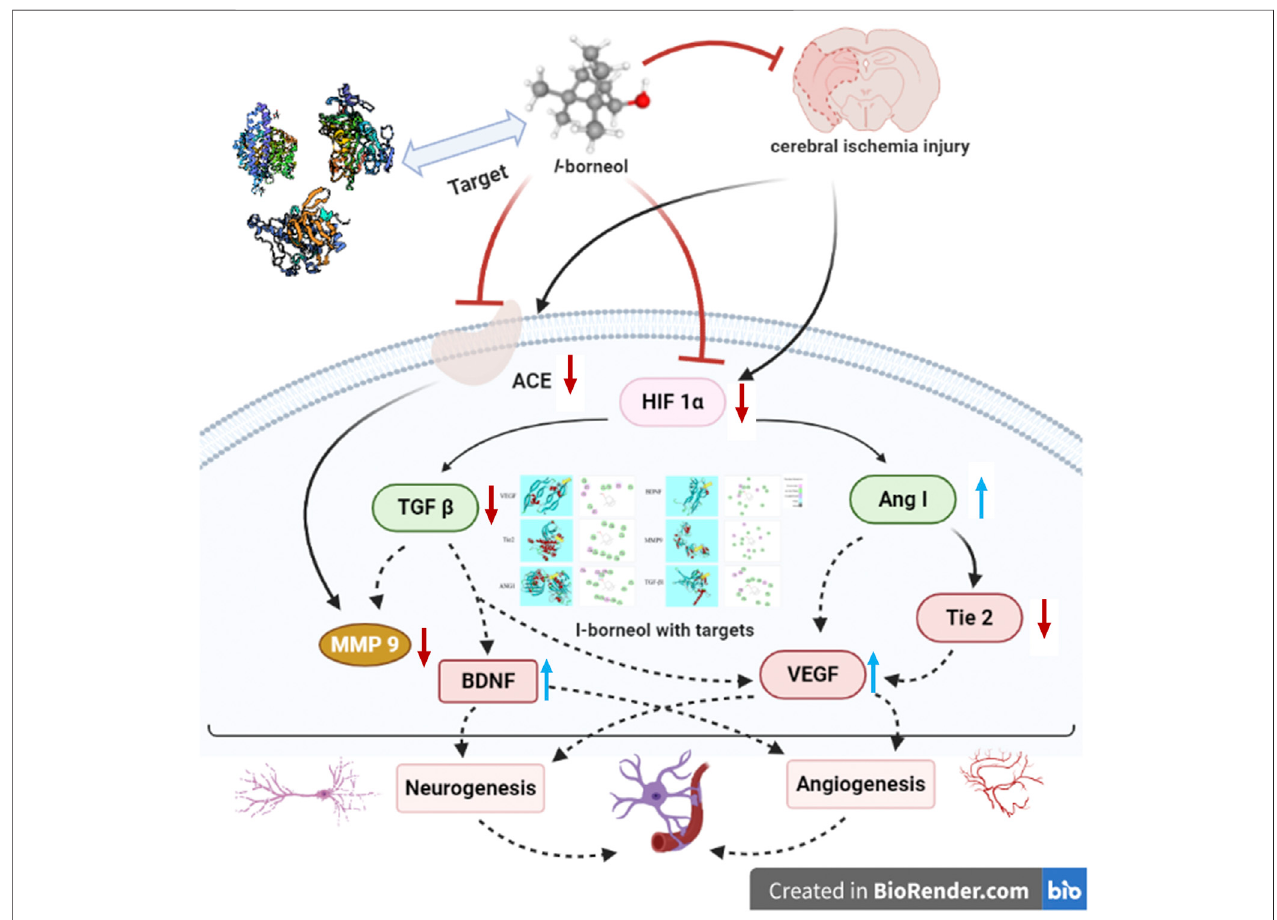
FIGURE 12 | Schematic presentation of a proposed mechanism for the protective role of l -borneol against cerebral ischemia injury (https://app.biorender.com/). Red arrows represent an inhibition effect; Blue arrows represent an enhancement effect.